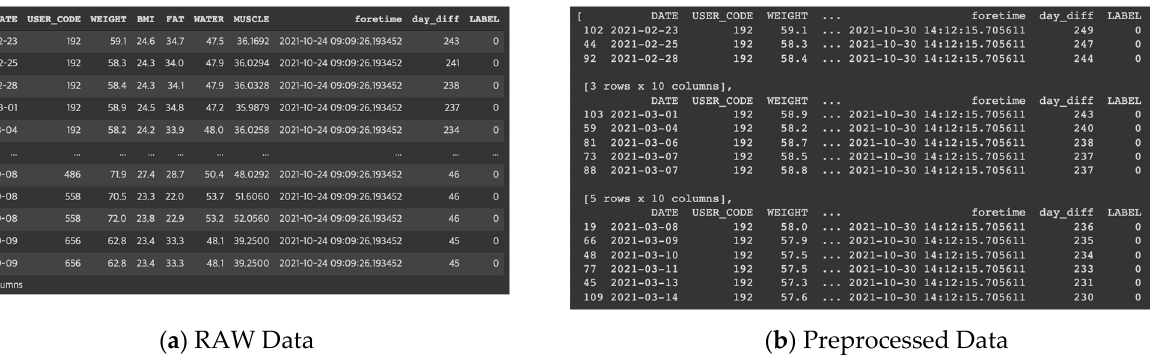
Figure 1. ( a ) Raw data collected from a wearable device; ( b ) Data set preprocessed per week. ‘day_diff’ indicates a derived variable. The value 249 means the number of days between the data collection time and the date of 2 October 2021, which has been taken as the standard in this study.